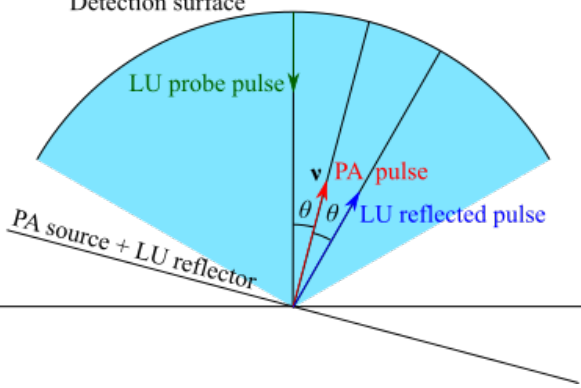
Figure 3. Limited view issue in PA and laser ultrasonic (LU) imaging.